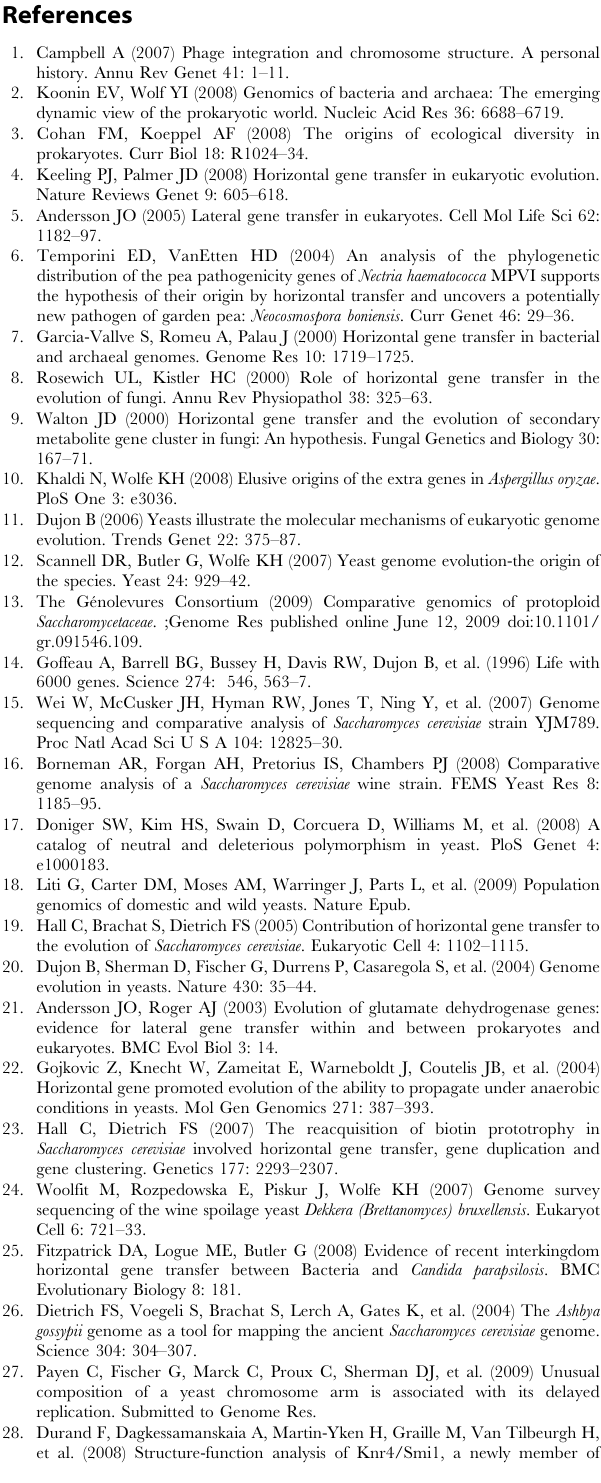
Table S5 Primers used to amplify the serine recombinase